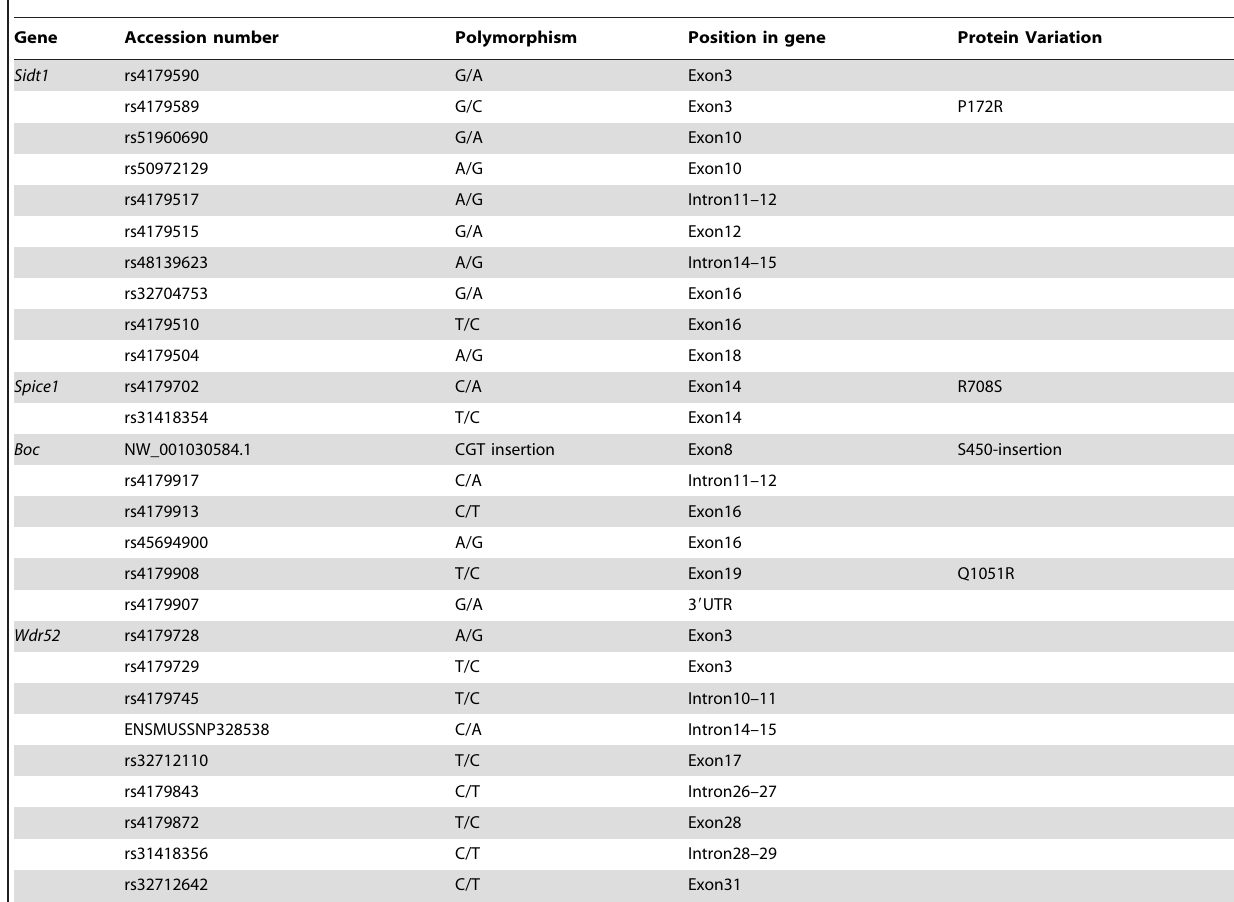
Table 1. Summary of genomic DNA sequencing results in the candidate interval.